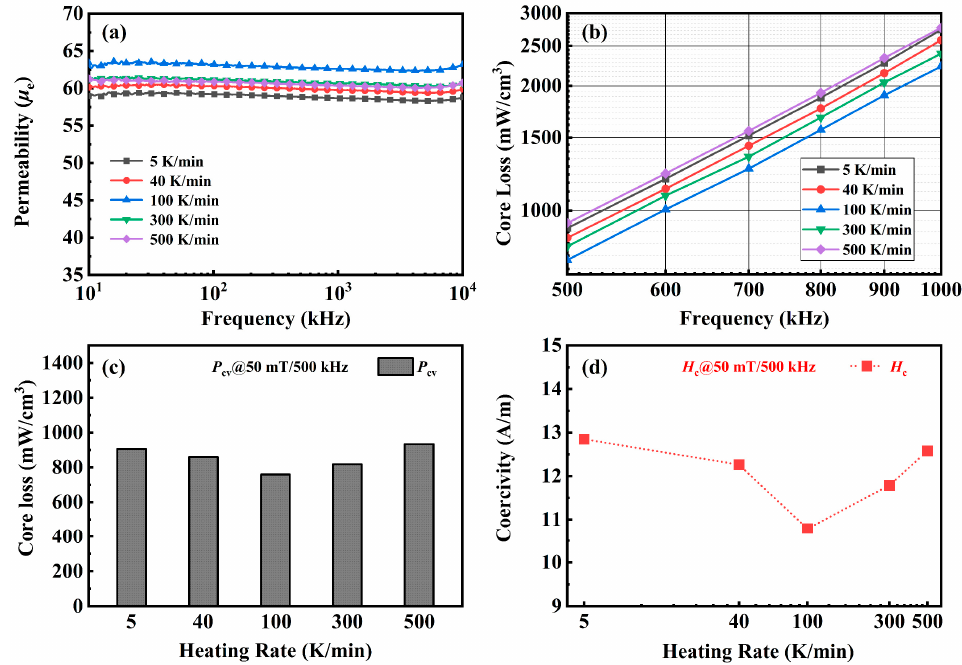
Figure 3. ( a ) µ e , ( b ) P cv , ( c ) histogram of P cv , and ( d ) H c change curve of Fe 74.75 Si 8 B 10 P 3 C 2 Nb 1.5 Cu 0.75 NPCs annealed at different HR and the same HT of 60 min.